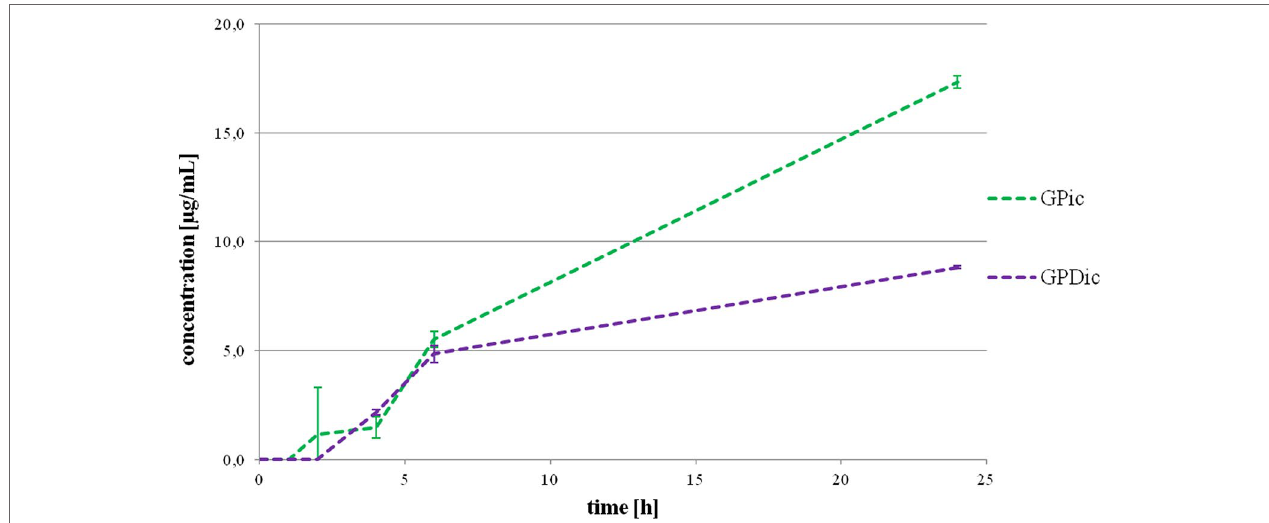
FIGURE 2 | Intracellular gliclazide concentration during a 24-h incubation with probiotics without the presence (GPic) and in the presence of deoxycholic acid